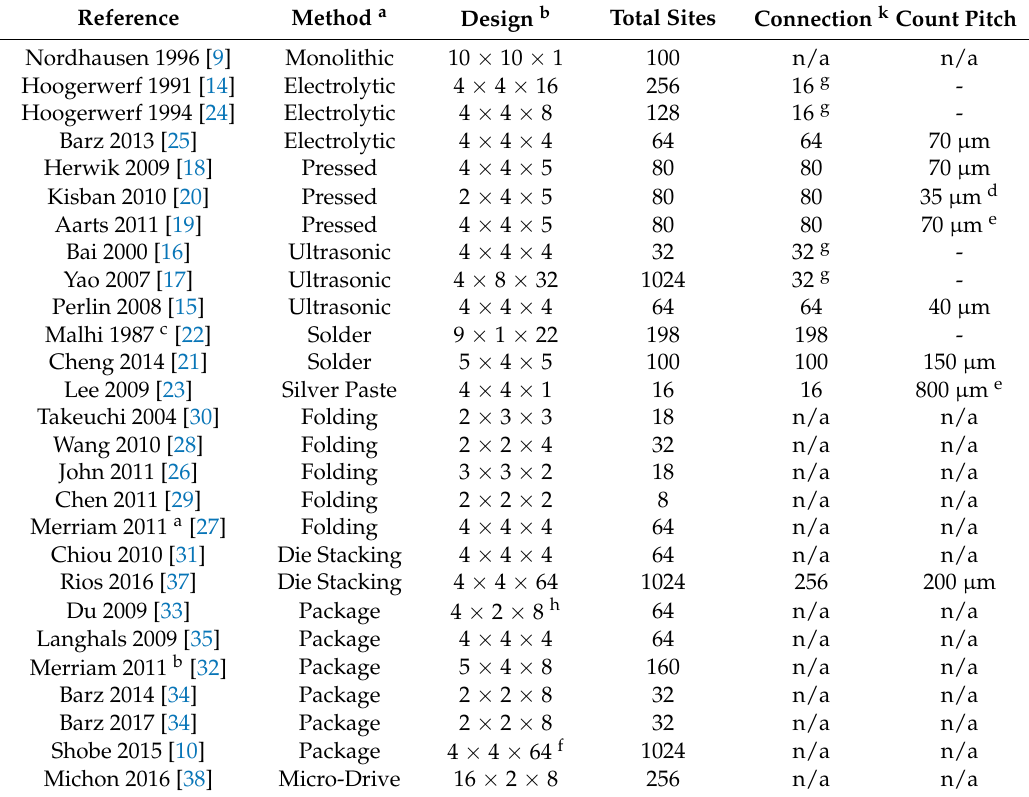
Table 1. 3-D Probe Fabrication